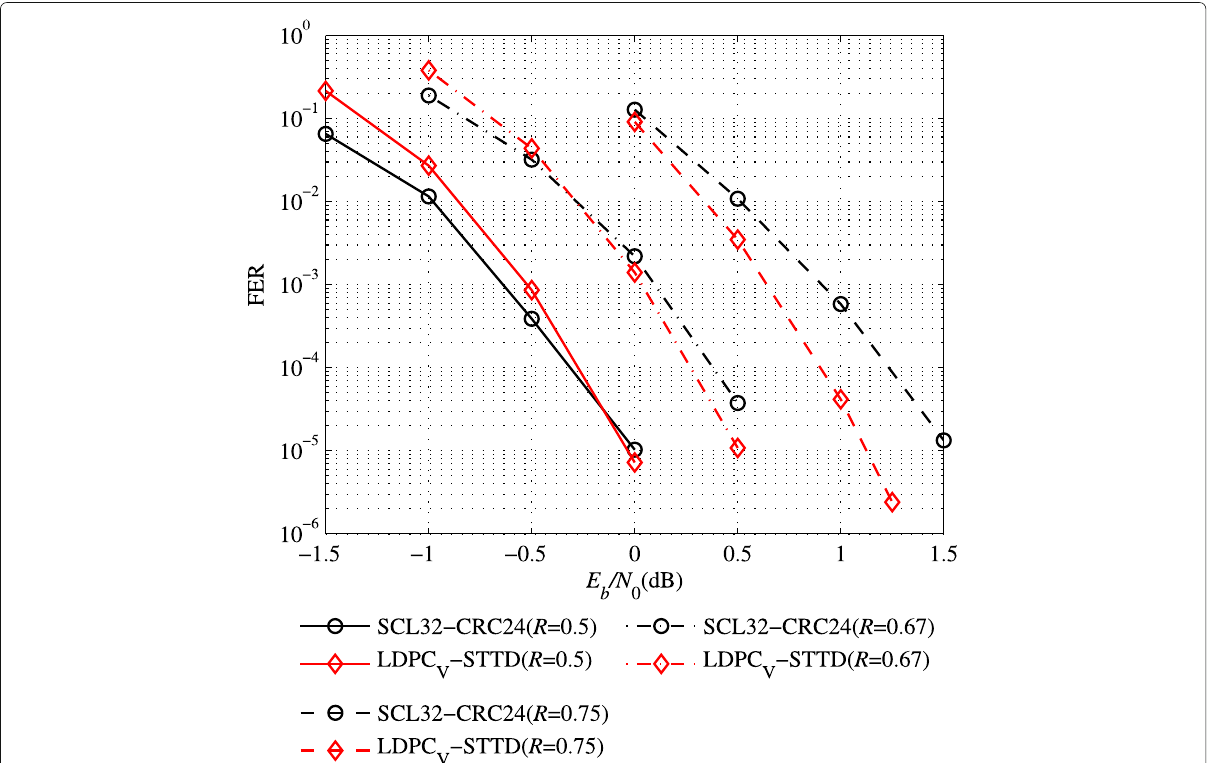
Fig. 7 FER performance of 2 × 2 polar-coded STTD system and state-of-the-art LDPC-based STTD system. The frame error rate performance of polar-coded STTD system with two transmit antennas and two receive antennas, comparing with the state-of-the-art LDPC-coded STTD